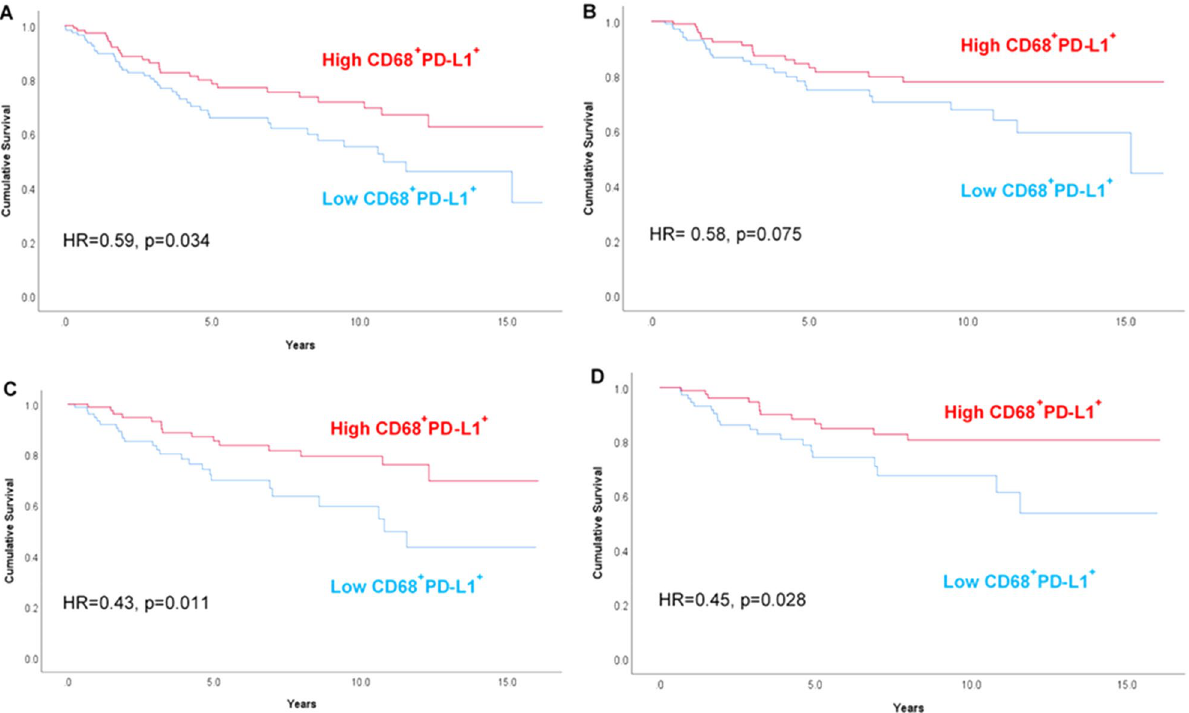
Figure 3. Kaplan–Meier plots stratified by stromal CD68 + PD-L1 + for ( A ) overall survival and ( B ) breast cancer-specific survival in all patients; ( C ) overall survival and ( D ) breast cancer-specific survival for patients who received chemotherapy. A univariate Cox hazard ratio and p value is inserted within each graph.